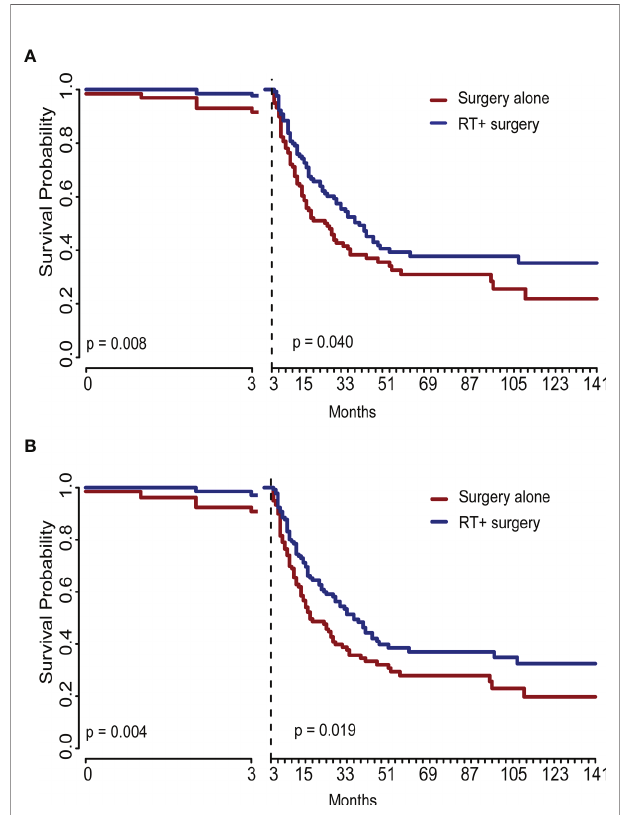
FIGURE 5 | This graph showed the landmark analysis of the unadjusted original cohort. The difference between treatments remained signi fi cant at different periods either in sarcoma-speci fi c survival (A) or in overall survival (B) . RT,